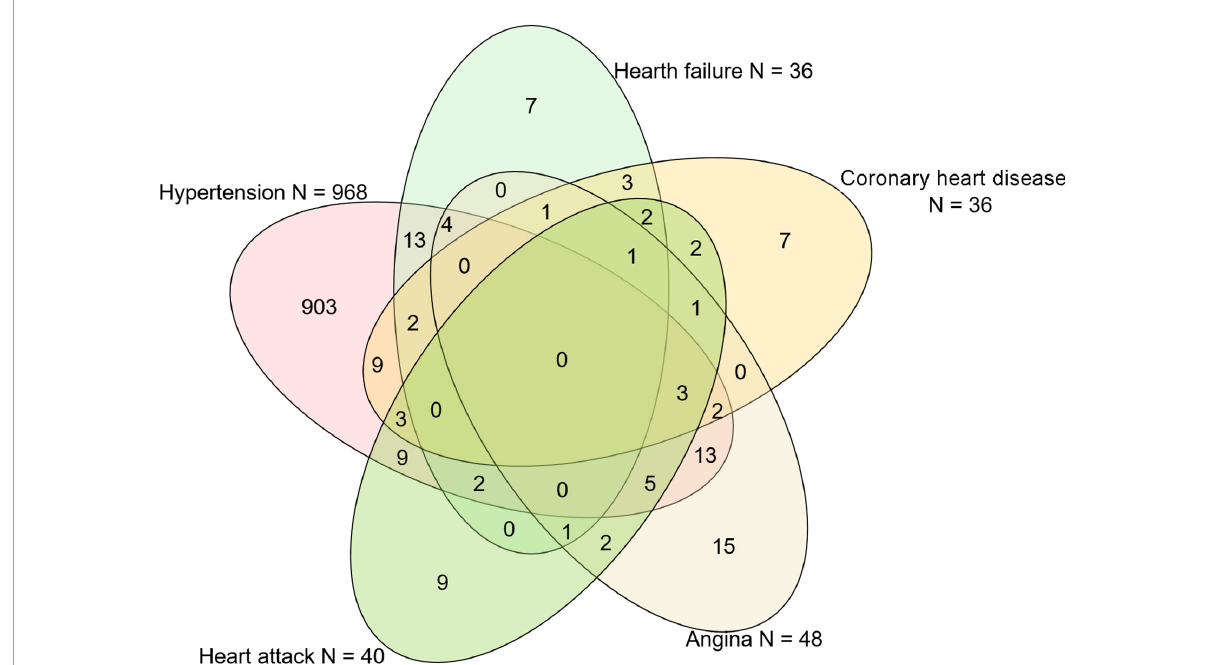
FIGURE2 Venn diagram of individuals’ distribution in each subgroup of cardiovascular diseases